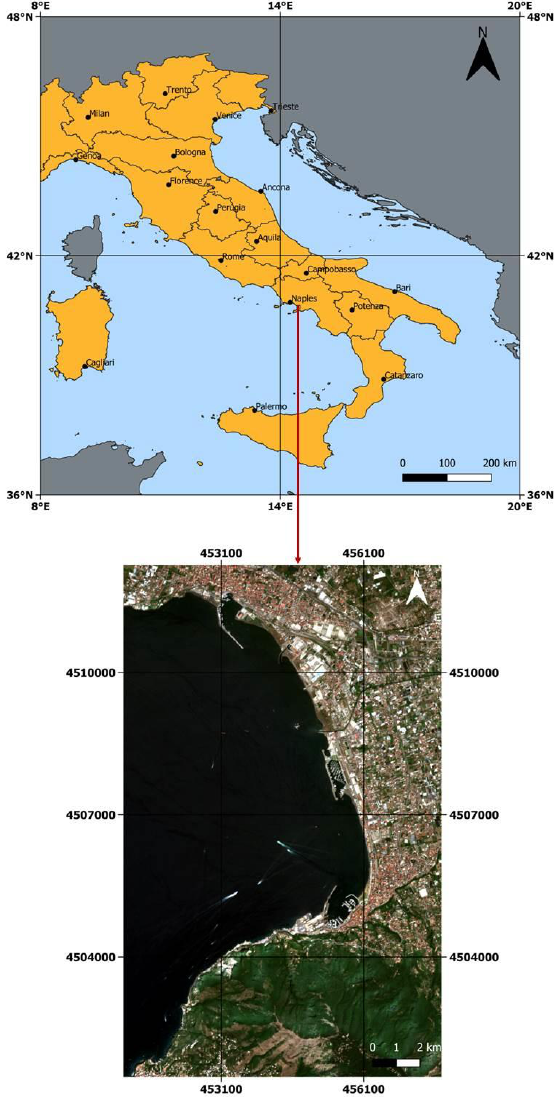
Figure 1. The study area: upper, localization of the study area in equirectangular projection and WGS84 geographic coordinates (EPSG: 4326); lower, visualization in RGB composition of Sentinel-2 images in UTM/WGS 84 plane coordinates expressed in meters (EPSG: 32632).